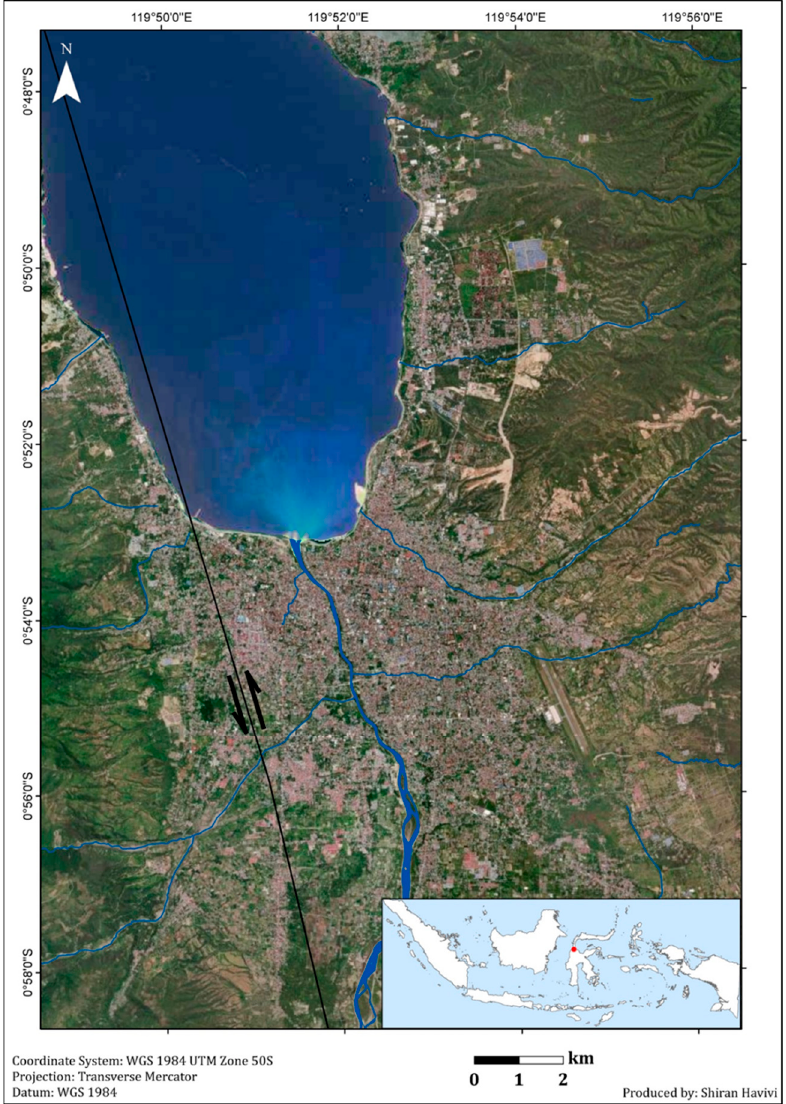
Figure 3. Research area: Palu, Central Sulawesi Province, Indonesia. Pre-event Sentinel-2 image (in visible bands 2—blue, 3—green, and 4—red) from 27 September 2018. The black line represents the Palu-Koro Fault (PKF). The black arrows show the dominate left-lateral movement of PKF, with trend of NNW–SSE and N-S.